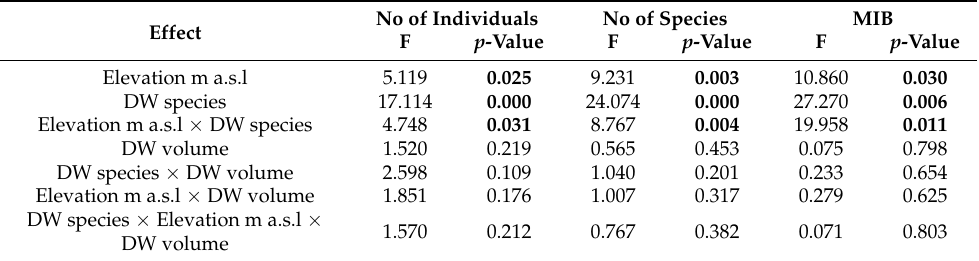
Table 2. Results of multivariate analysis of variance based on the general linear model (GLM) for the carabids number and biomass, including the altitude of the deadwood (DW) plots and its quantity. No of Individuals No of Species MIB Effect F p -Value F p